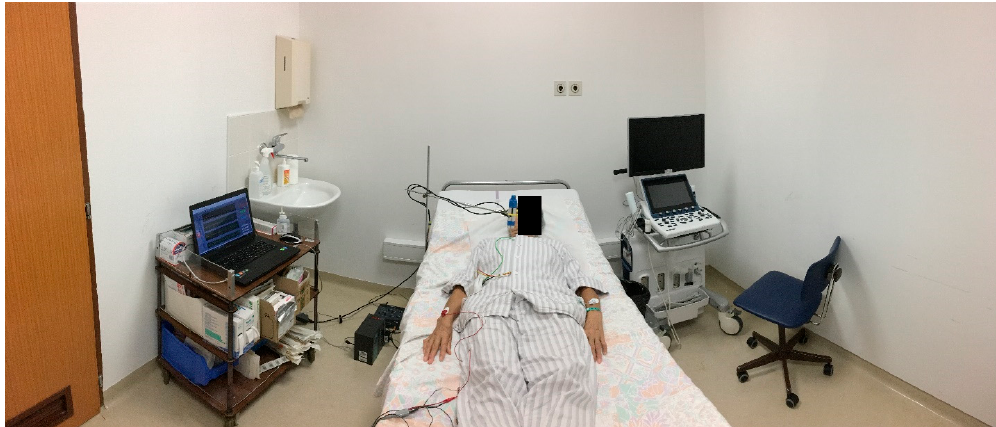
Figure 5. Clinical experiment non-contact measuring device setup.